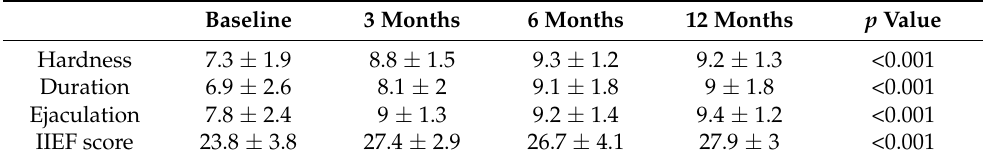
Table 5. Comparison of changes of sexual function (as assessed by IIEF) from baseline to follow-up in OSA patients with CPAP use. Repeated measures ANOVA; mean ±